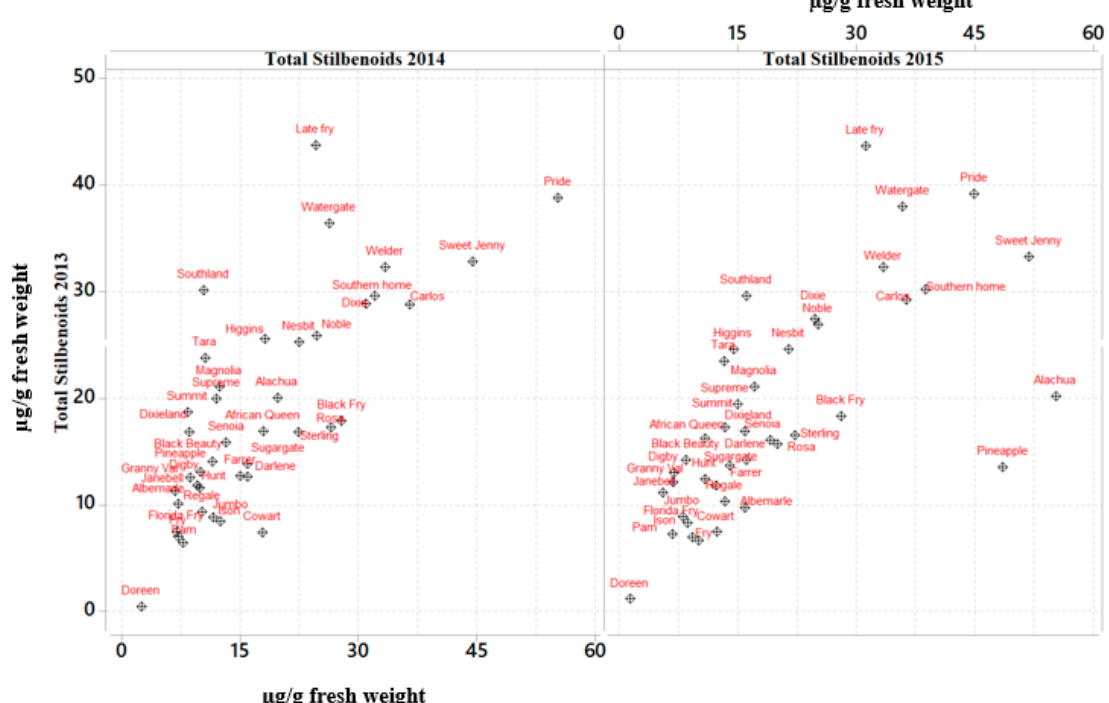
Figure 1. Scatter Plot showing differences in the total content of stilbenoids among muscadine cultivars.